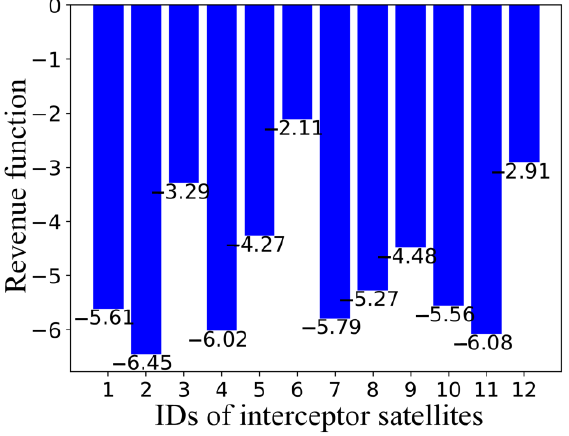
Figure 7. Revenue function when t i = 60,000 s. (2) Defence task allocation and interception orbit planning when t i = 120, 000 s.